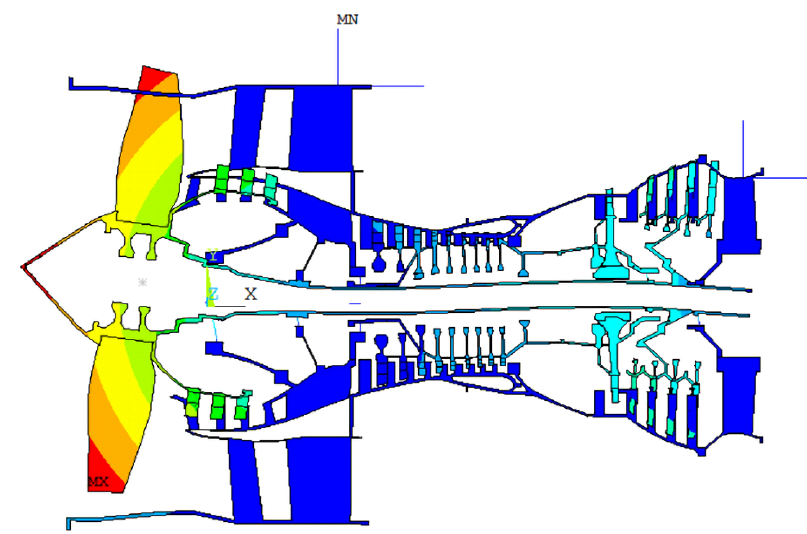
Figure 10. The second critical speed modal shape.